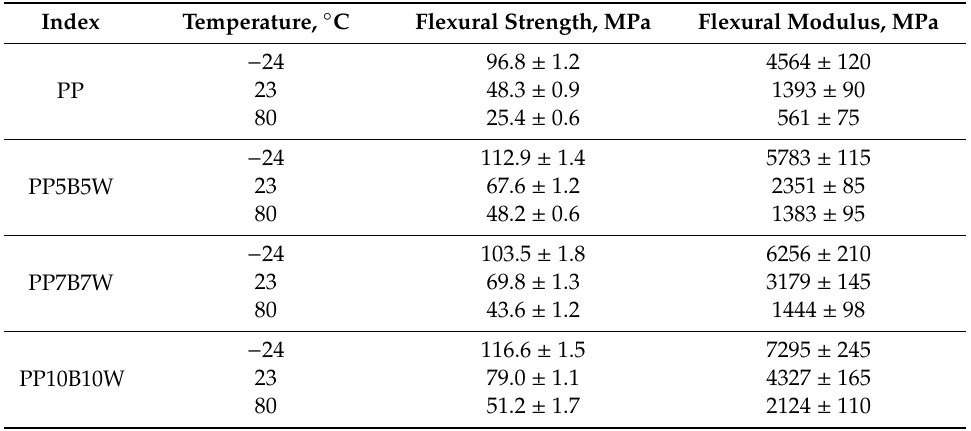
Table 3. The influence of temperature on the change in the mechanical properties of the tested materials. Index Temperature, ◦ C Flexural Strength, MPa Flexural Modulus,